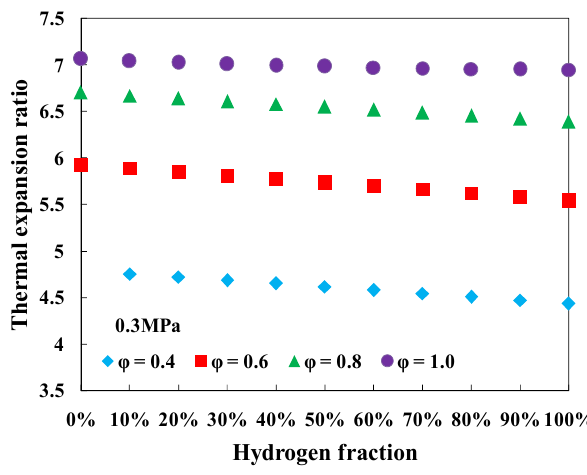
Figure 10. Thermal expansion ratio plotted against hydrogen